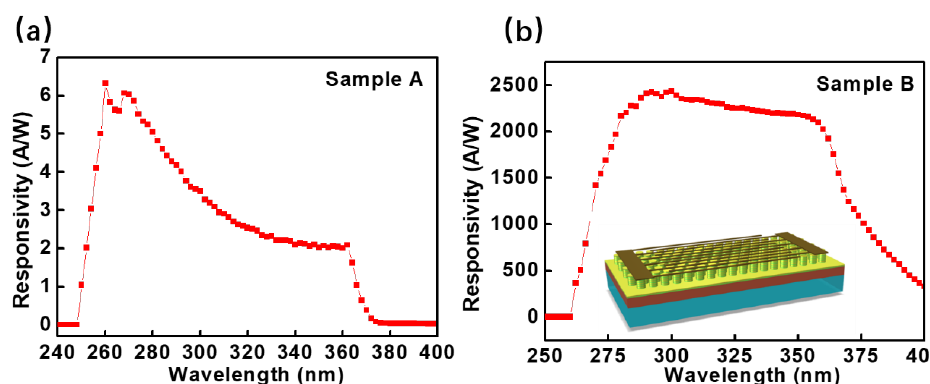
Figure 3. ( a ) Spectral responsivity values of sample A as a function of wavelength at 7 V bias, ( b ) spectral responsivity values of sample B as a function of wavelength at 7 V bias. The inset shows the device diagram of sample B.